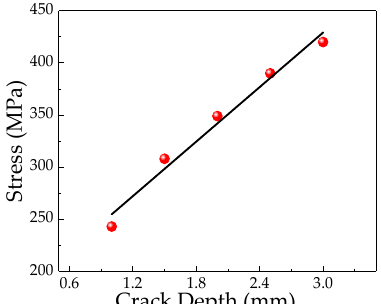
Figure 7. Relationship between the stress at crack tip and the crack depth.